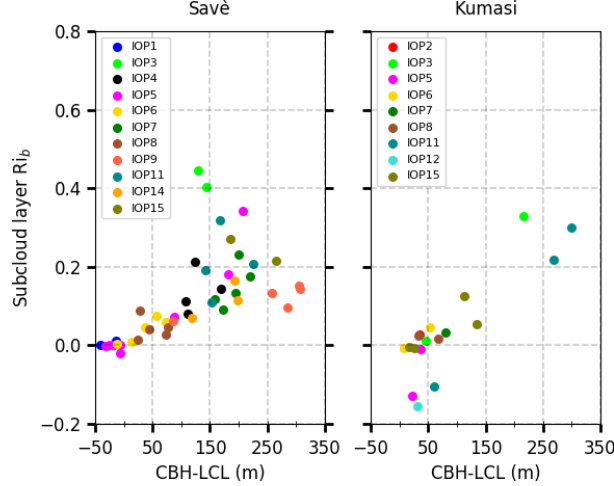
Figure 6. Bulk Richardson number ( Ri b ) in the sub-cloud layer ver- sus height difference between cloud base height (CBH) and lifting condensation level (LCL) estimated from the radiosondes launched during the stratus phase at Savè and at Kumasi. Colours stand for the different